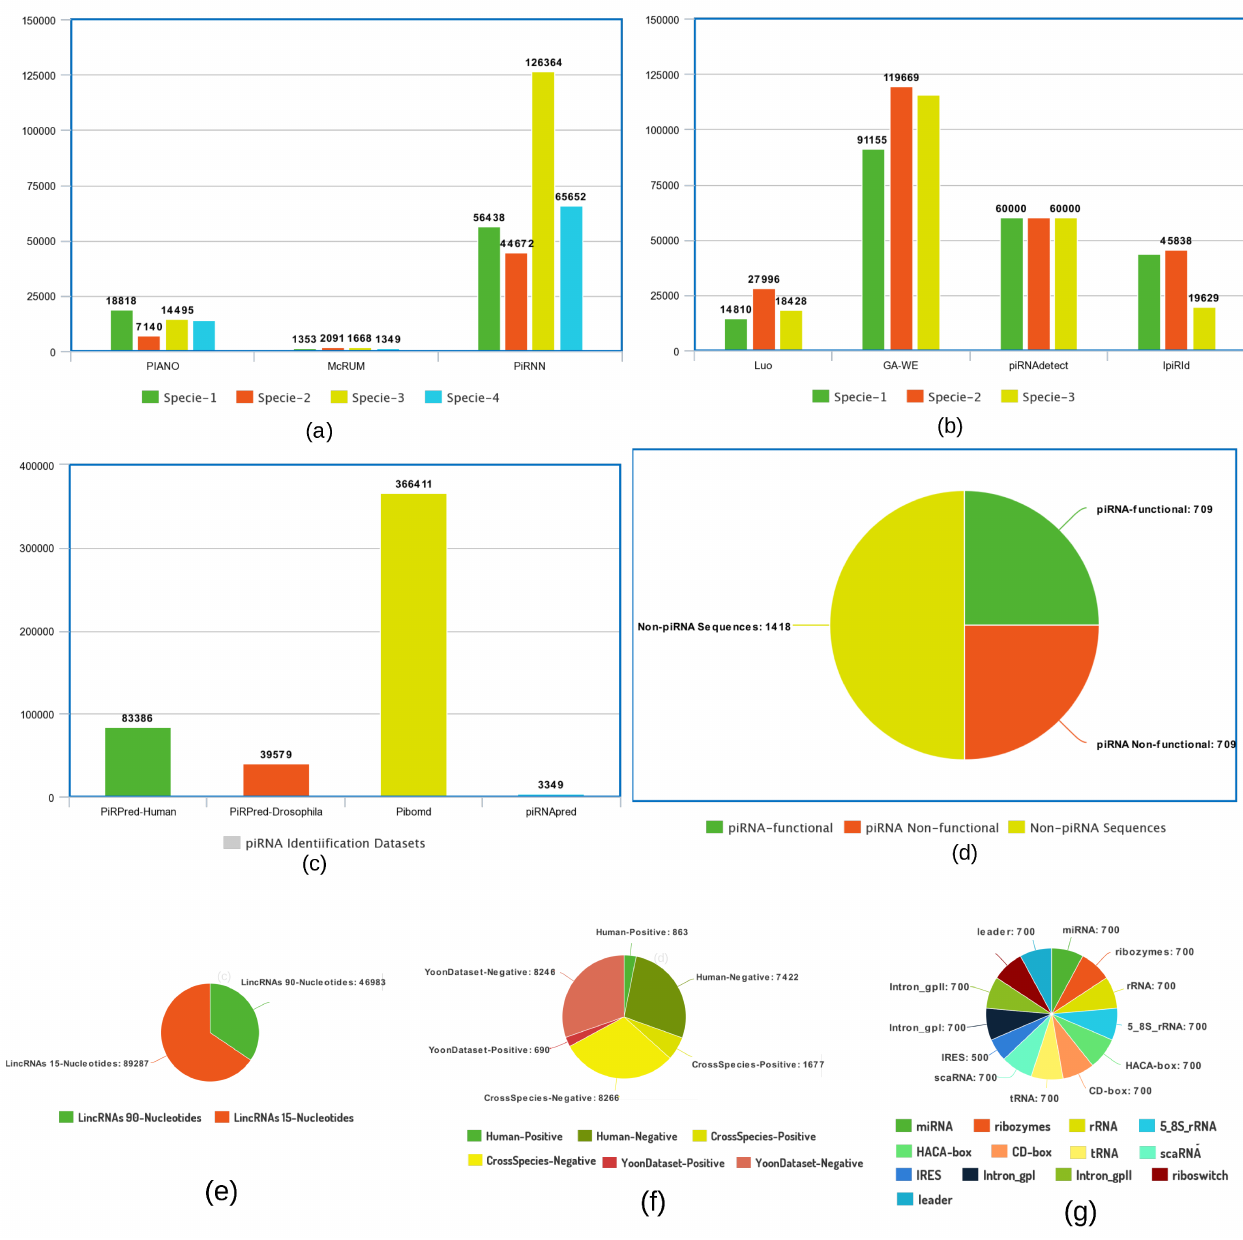
Figure 3. Statistics of different benchmark datasets used to identify piRNA ( a ) 1-Layer 4 Species Datasets, ( b ) 1-Layer 3 Species Datasets, ( c ) 1-Layer 2 and 1 Species Datasets, ( d ) 2-Layer Datasets, where Species = H. sapiens , M. musculus